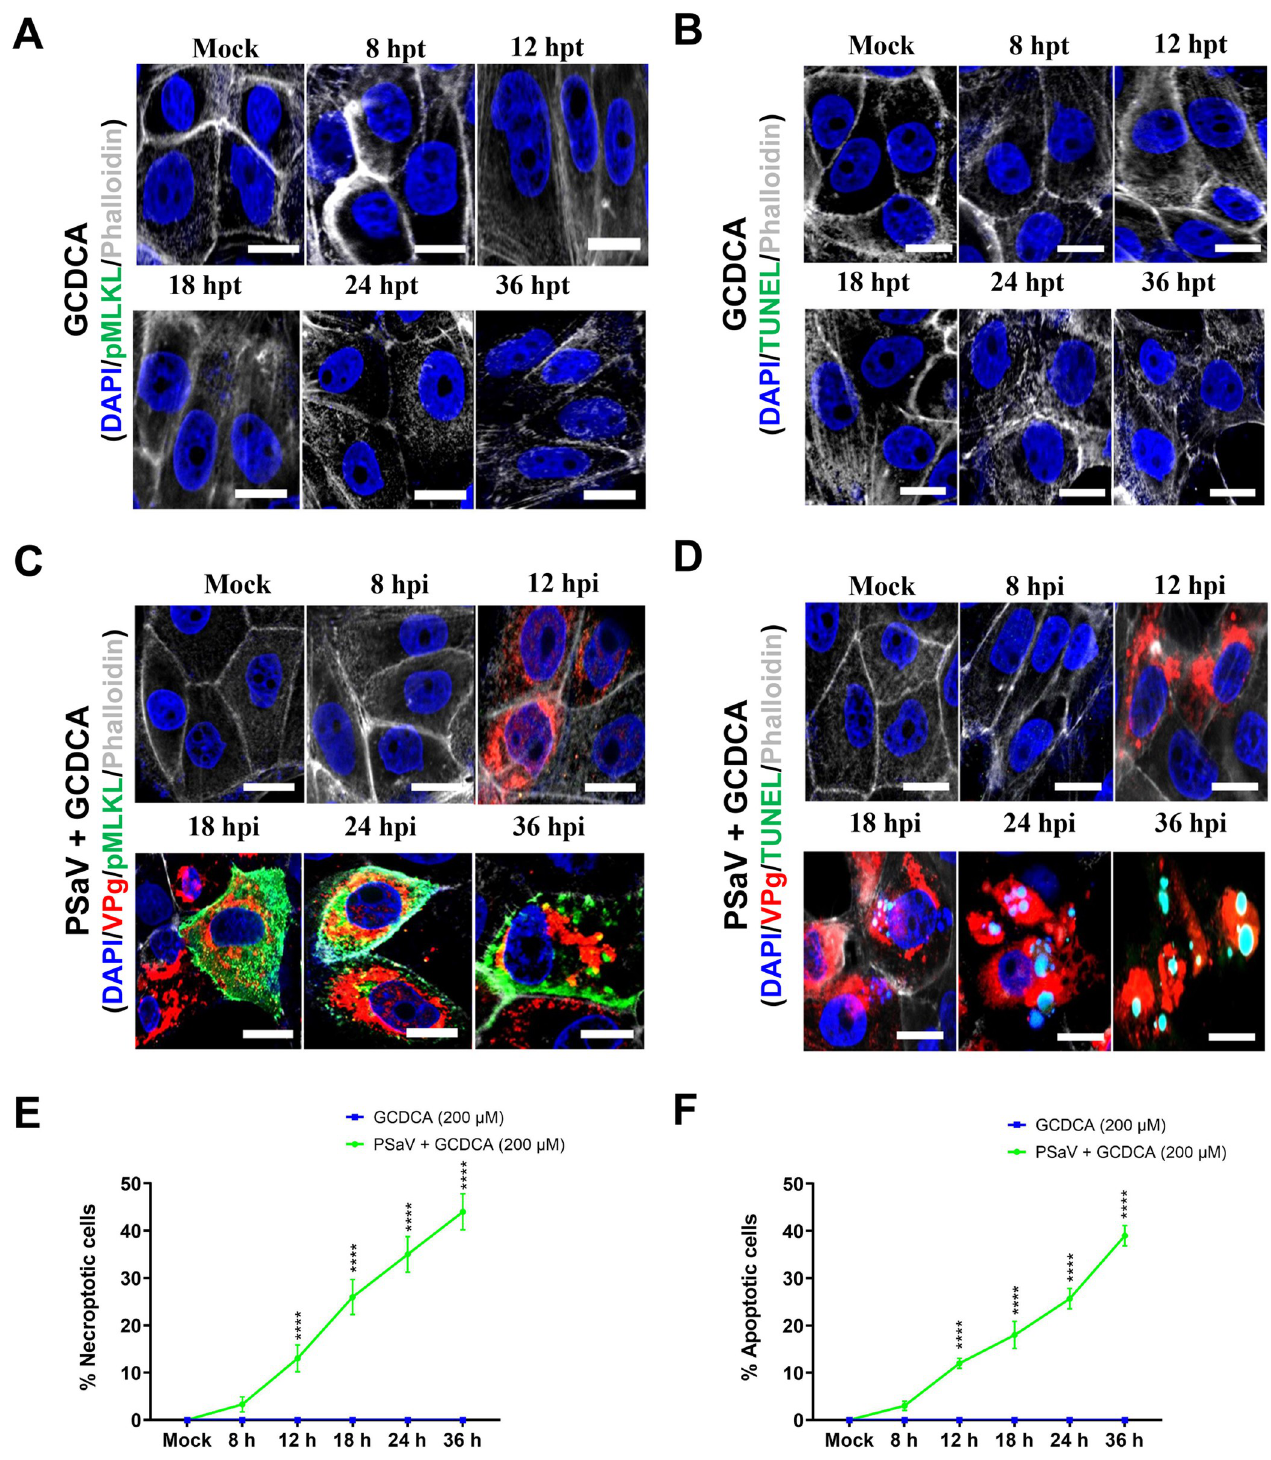
Fig 3. PSaV-induced apoptosis and necroptosis examined by confocal microscopy. (A, B) LLC-PK cells were treated with 200 μ M GCDCA for the indicated time points and processed for IF assay to detect necroptotic cells using an anti-pMLKL antibody (A) or for TUNEL assay to detect apoptotic cells (B). (C, D) LLC-PK cells mock-infected or infected with PSaV Cowden strain (MOI = 1 TCID 50 ) in the presence of 200 μ M GCDCA and incubated for the indicated time points were processed for IF assay to detect the dual positive necroptotic cells with PSaV VPg antigen and pMLKL necroptotic marker (C) or for IF and TUNEL assays to detect the dual positive apoptotic cells with PSaV VPg antigen and TUNEL marker (D). The nuclei were stained with DAPI. Actin